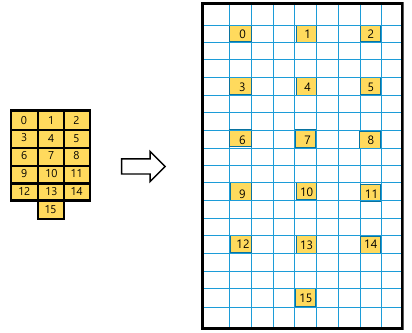
Figure 11. Three-fold frame extension example: Source cells are spatially mapped to the extended frame as uniformly as possible.